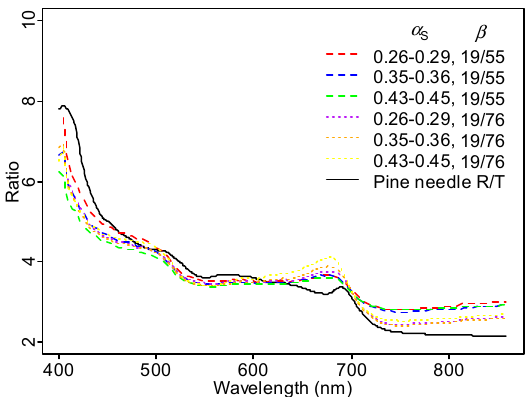
Figure 12. Ratio of Scots pine canopy TOC reflectance close to hot spot ( β = 19 ◦ ) to that at dark spot ( β = 76 ◦ ) and nadir ( β = 55 ◦ ) scaled by a factor of three (for different sunlit fraction α S intervals, dashed lines), plotted together with the ratio of Scots pine needle reflectance to transmittance measured in situ [40] (solid line).